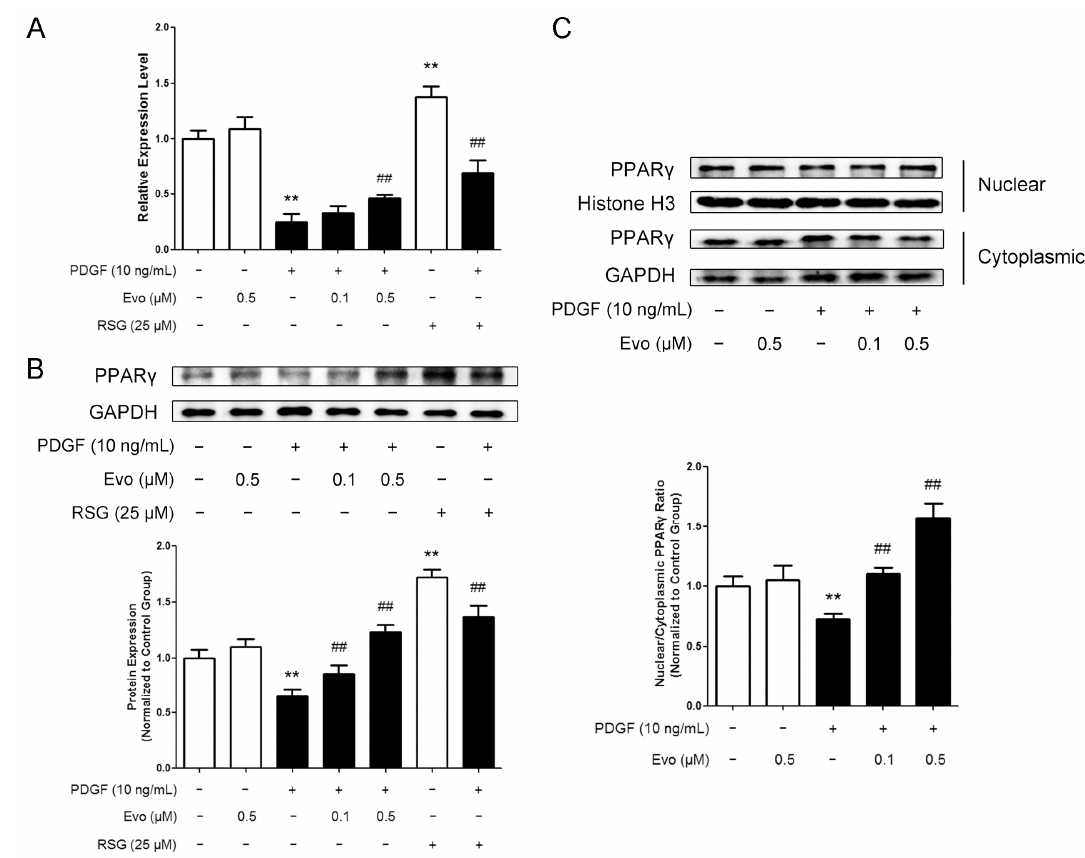
Figure 3. Evodiamine activates peroxisome proliferator-activated receptor γ (PPAR γ ) in PDGF-BB-stimulated VSMCs. ( A ) VSMCs were pretreated with evodiamine or rosiglitazone for 6 h and then stimulated with PDGF-BB for another 24 h. RT-qPCR was used to measure the mRNA expression levels of PPAR γ ; ( B ) Western blot was used to measure the protein levels of PPAR γ . The signal ratio of PPAR γ to the internal control GAPDH is shown at the bottom; ( C ) Nuclear and cytoplasmic proteins were extracted separately, and Western blot was used to measure the protein levels of PPAR γ in both fractions. The ratio of nuclear/cytoplasmic PPAR γ is shown at the bottom. Evo, evodiamine. RSG, rosiglitazone. Data are presented as mean values ± SD of three independent experiments. ** p < 0.01 compared with the control group; ## p < 0.01 compared with the PDGF-BB-stimulated group.